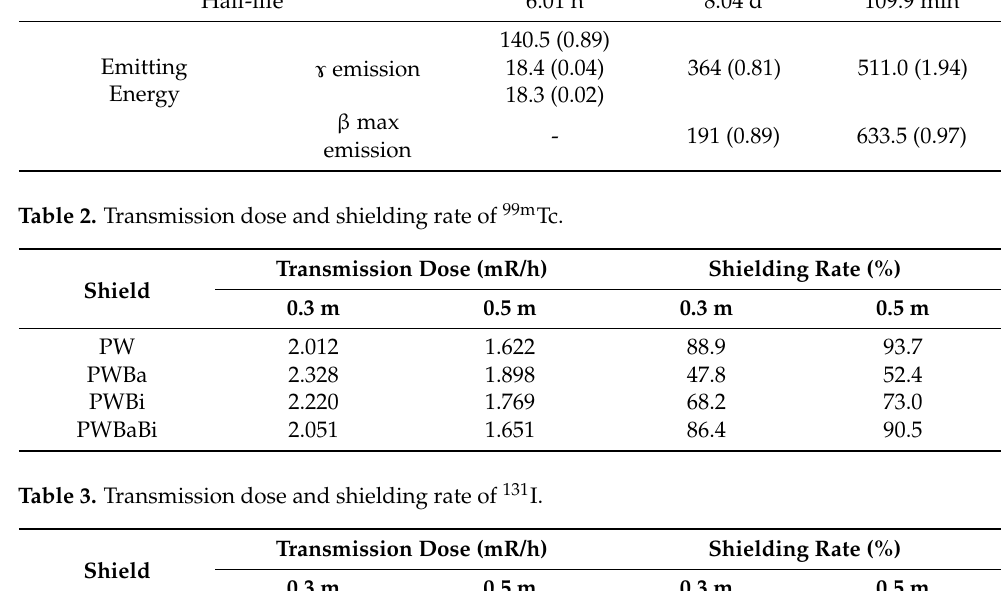
8 of 13 Figure 6. Comparative analysis of the cross-sectional images of single and composite materials of shield samples: ( a ) PW-85 (W) and ( b ) PWBaBi-80 (W, Ba, Bi). The circled portion labeled A exhib- ited the encapsulation phenomenon progressed by polymer coating around the particles of the shielding material, and B presents the state of the agglomeration between the particles of the com-